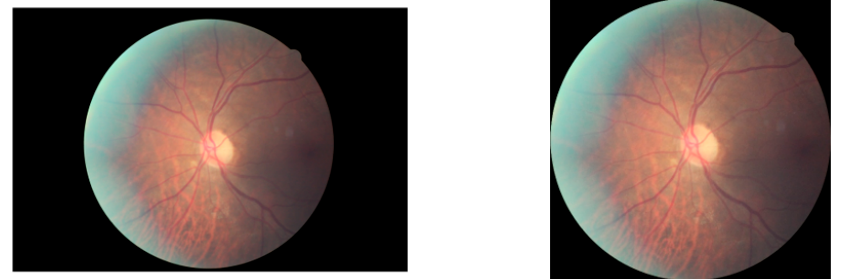
Figure 2. An example of source ( left ) and pre-processed ( right ) images (the image on the left is from the EyePaCS dataset [36]).